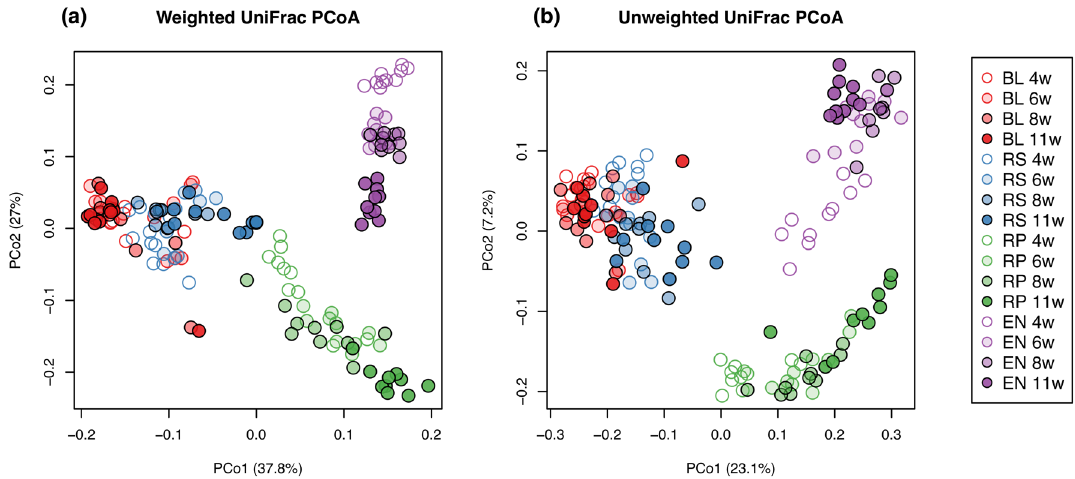
Figure 5. Principal coordinate analysis of weighted and unweighted UniFrac distance among all samples. BL, bulk soil; RS, rhizosphere; RP, rhizoplane; EN,